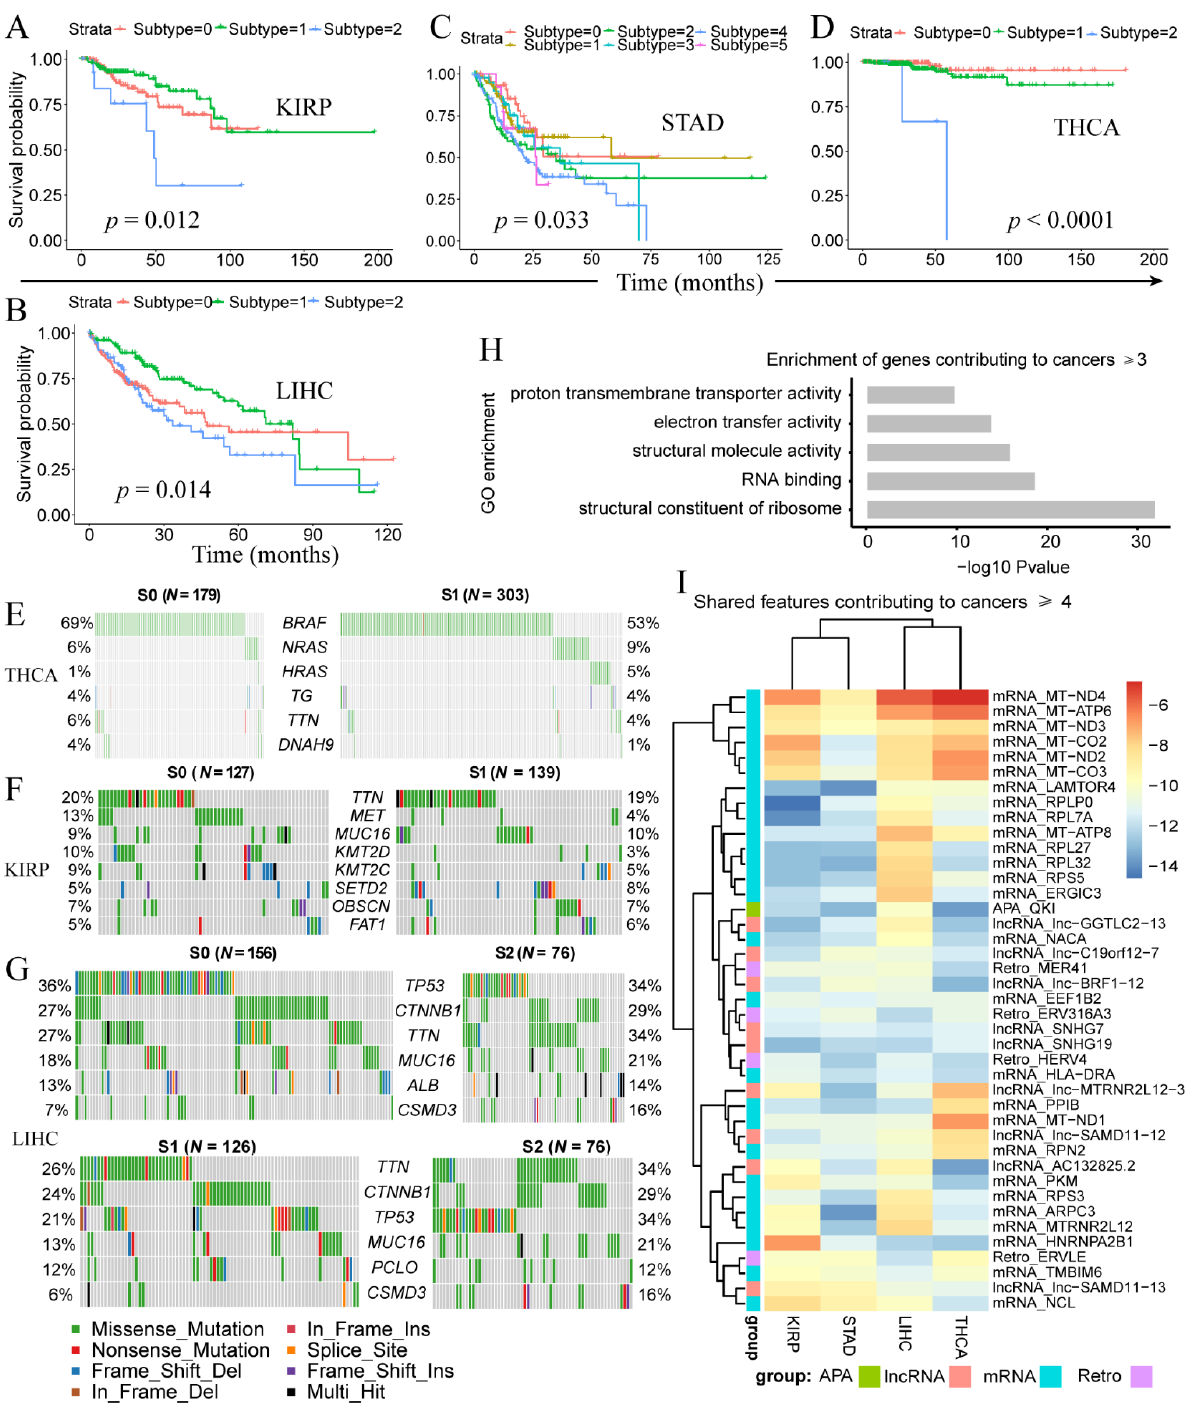
Figure 3. Disease subtypes identified by PipeOne in each cancer. ( A – D ) Disease subtypes and survival difference in KIRP ( A ), LIHC ( B ), STAD ( C ), and THCA ( D ). ( E – G ) Different frequencies of somatic mutations between cancer subtypes in THCA ( E ), KIRP ( F ), and LIHC ( G ). ( H ) Enriched gene ontology terms of subtype-associated features shared by at least three cancer types. ( I ) Subtype-associated features (many mitochondria genes) shared by at least four cancer